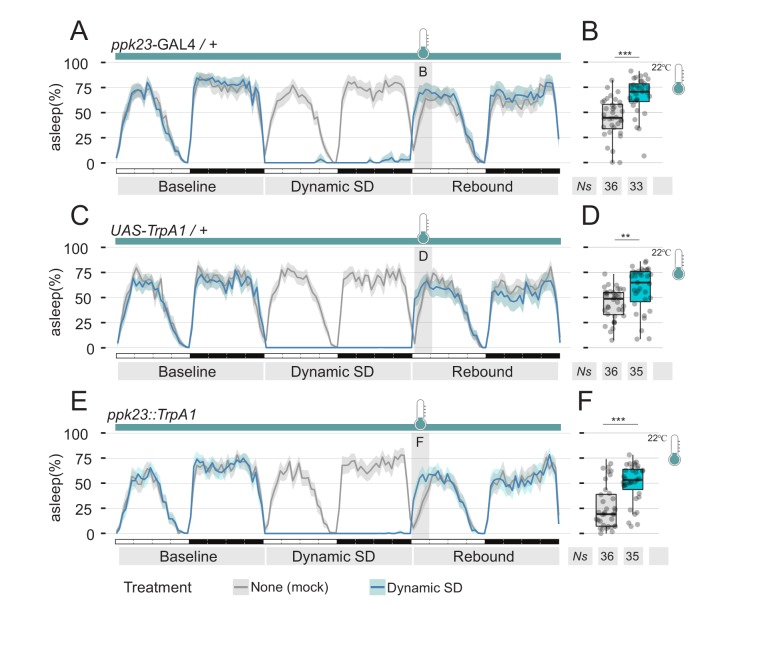
Temperature control conditions for experiments shown in Figure 5.(A, C, E) Same genotypes and treatment shown in Figure 5. Temperature is kept constant at 22°C for the length of the experiment. (B, D, F) Quantification of sleep rebound during ZT0-3 of rebound day for flies shown in A, C, E respectively.